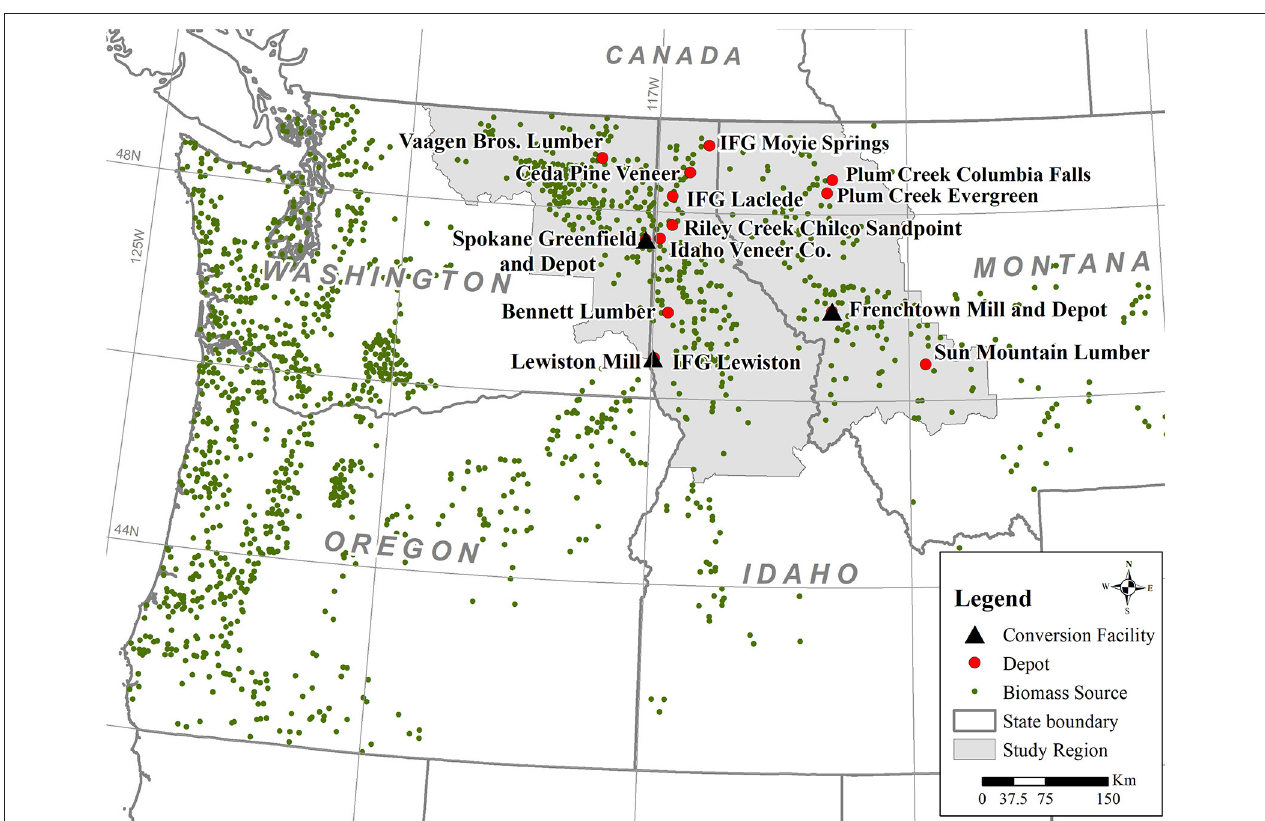
FIGURE 2 | Biomass source nodes and potential biorefinery and depot